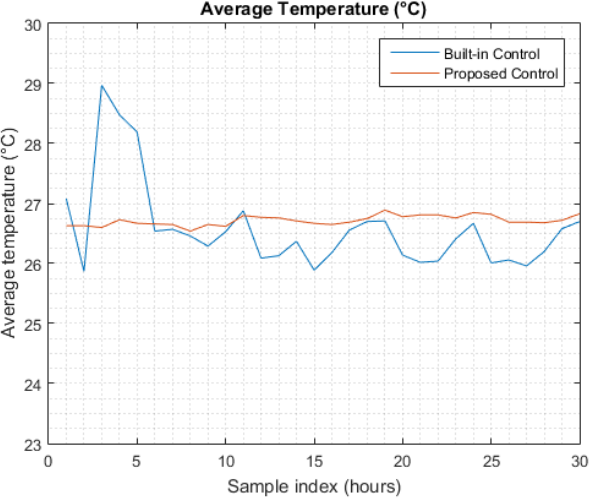
Figure 18. Average temperature with the built-in with 26.58 °C and the proposed control systems.